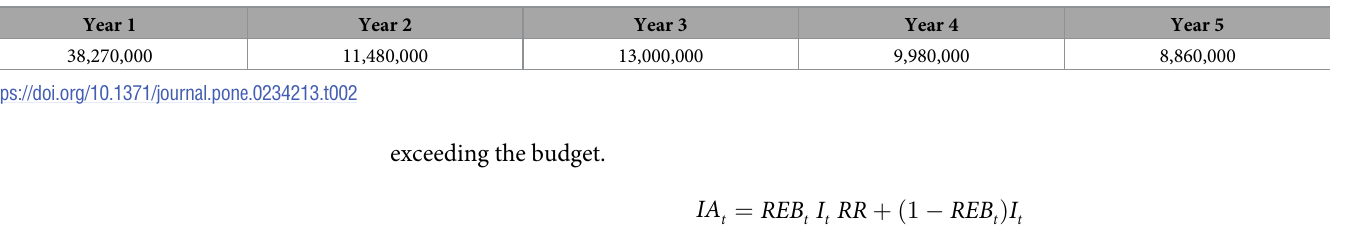
Table 2. Yearly costs for flood recession